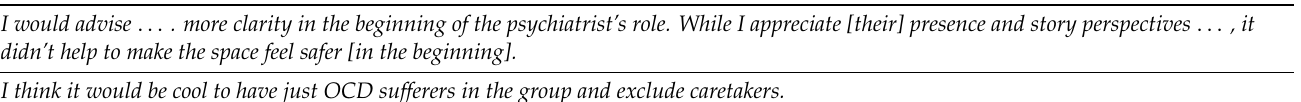
Table 6. Participant open-ended survey